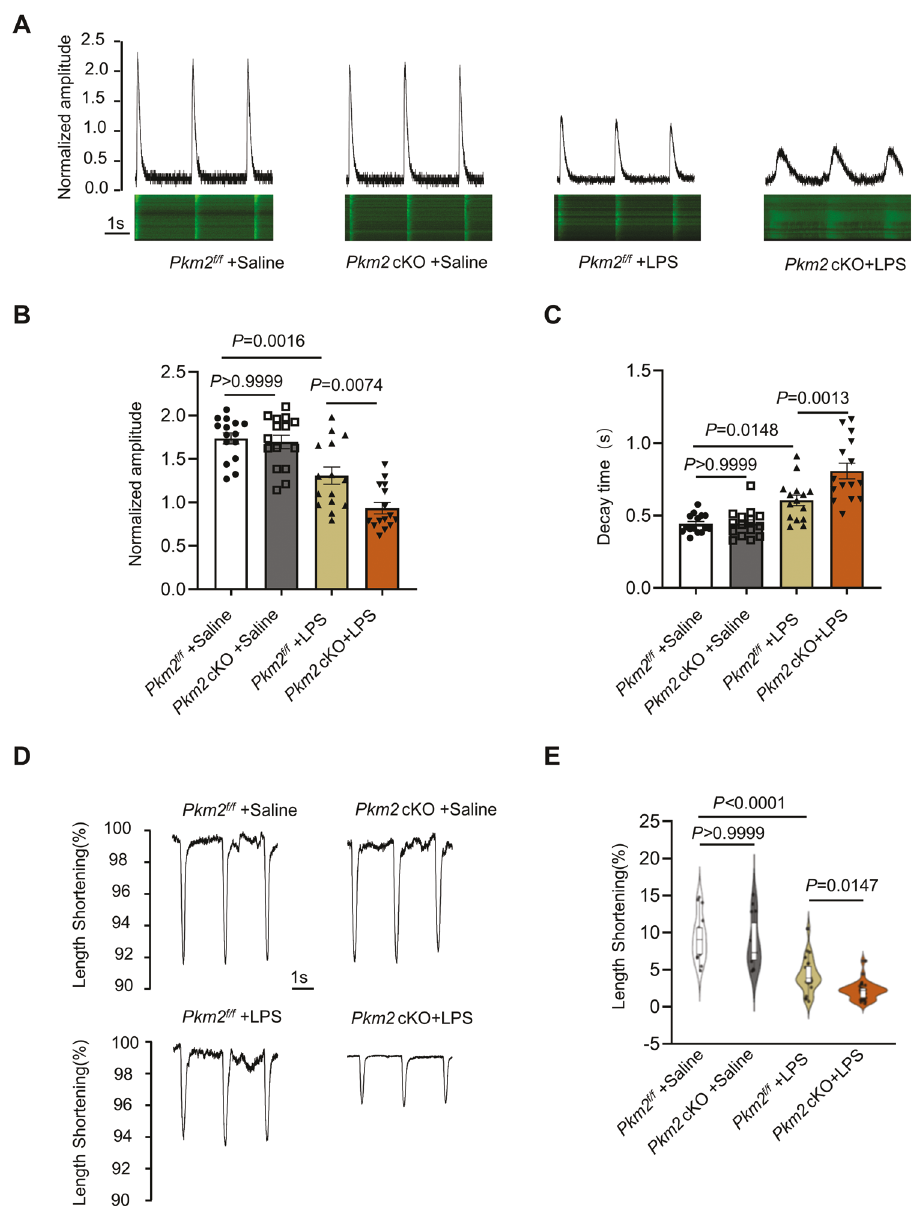
Fig. 6 PKM2 de fi ciency compromised cardiomyocyte contraction amplitude, calcium transients. A – C Representative calcium transient curve and quantitation of calcium transient amplitudes and decay time in AMCMs from Pkm2 cKO and Pkm2 f/f mice after saline or LPS administration, n = 15. D , E Cardiomyocytes contraction depicting cell shortening in cardiomyocytes isolated from Pkm2 cKO and Pkm2 f/f mice after saline or LPS administration, n = 24. Values represent the mean ±